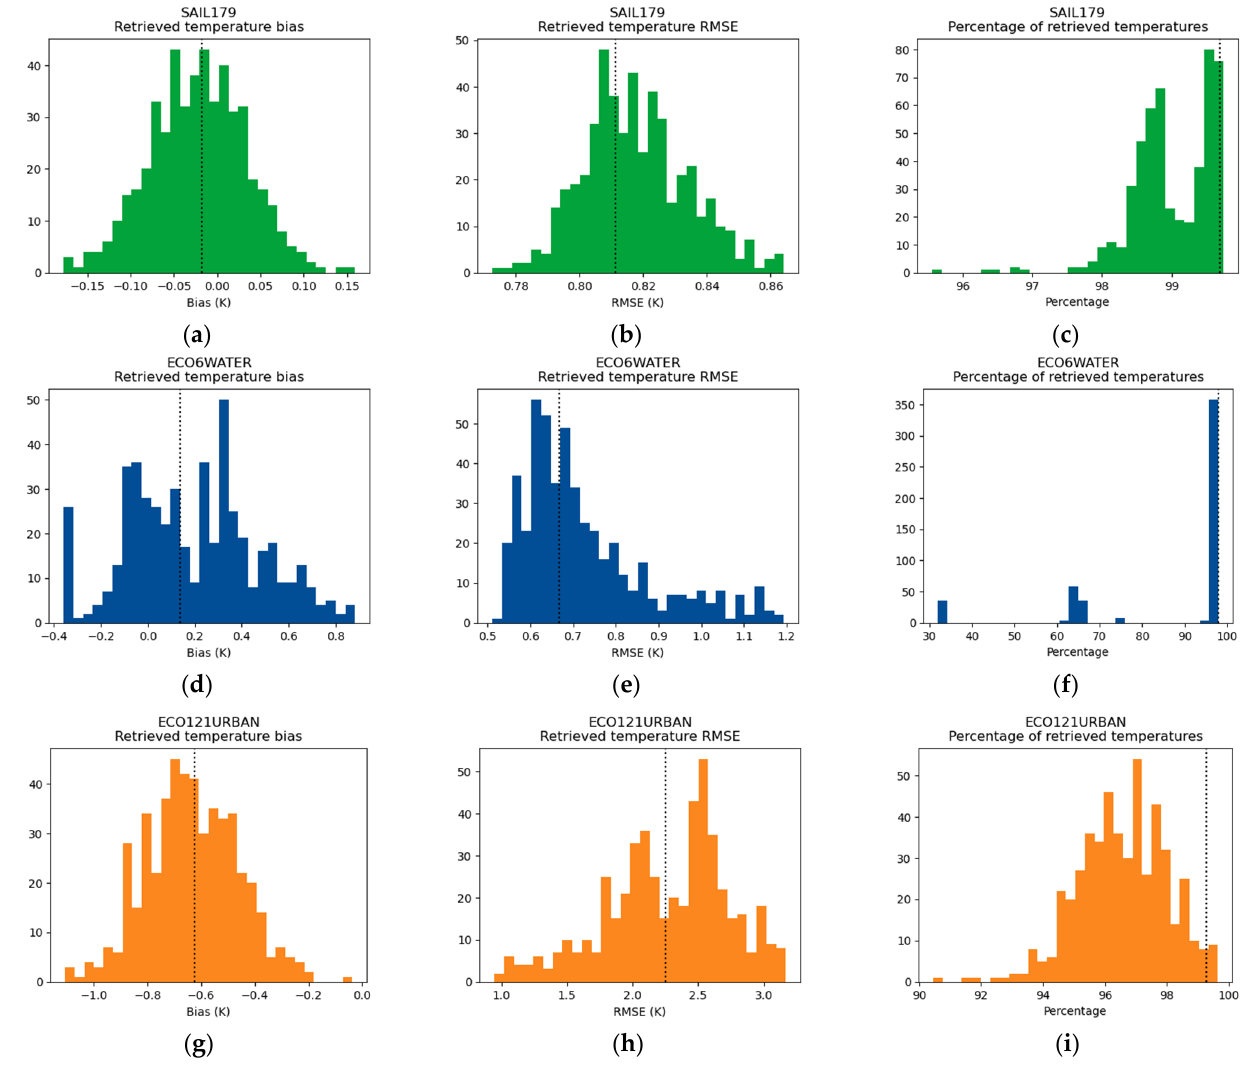
( i ) Figure 14. Bias, RMSE, and retrieved percentage obtained with DirecTES and Δ T (cid:2930)(cid:2918)(cid:2928)(cid:2915)(cid:2929)(cid:2918) = 3 K , with TIR information only, both sources of uncertainty, and 500 random divisions of the spectral library for vegetation ( a – c ), water ( d – f ) and urban materials ( g – i ). The dashed line represents the value obtained without dividing the spectral library. Figure 15 shows the results obtained adding VNIR-SWIR information (as in Section 4.2) with Δ𝜌 (cid:3047)(cid:3035)(cid:3045)(cid:3032)(cid:3046)(cid:3035) = 0.1 . The bias obtained with the whole library is still quite representa- tive of the results with the division of the library (with variations of a few tenths of a degree). Yet, we note that the percentage of retrieved temperatures is significantly lower with the divided library than with the whole library. This is particularly clear with water